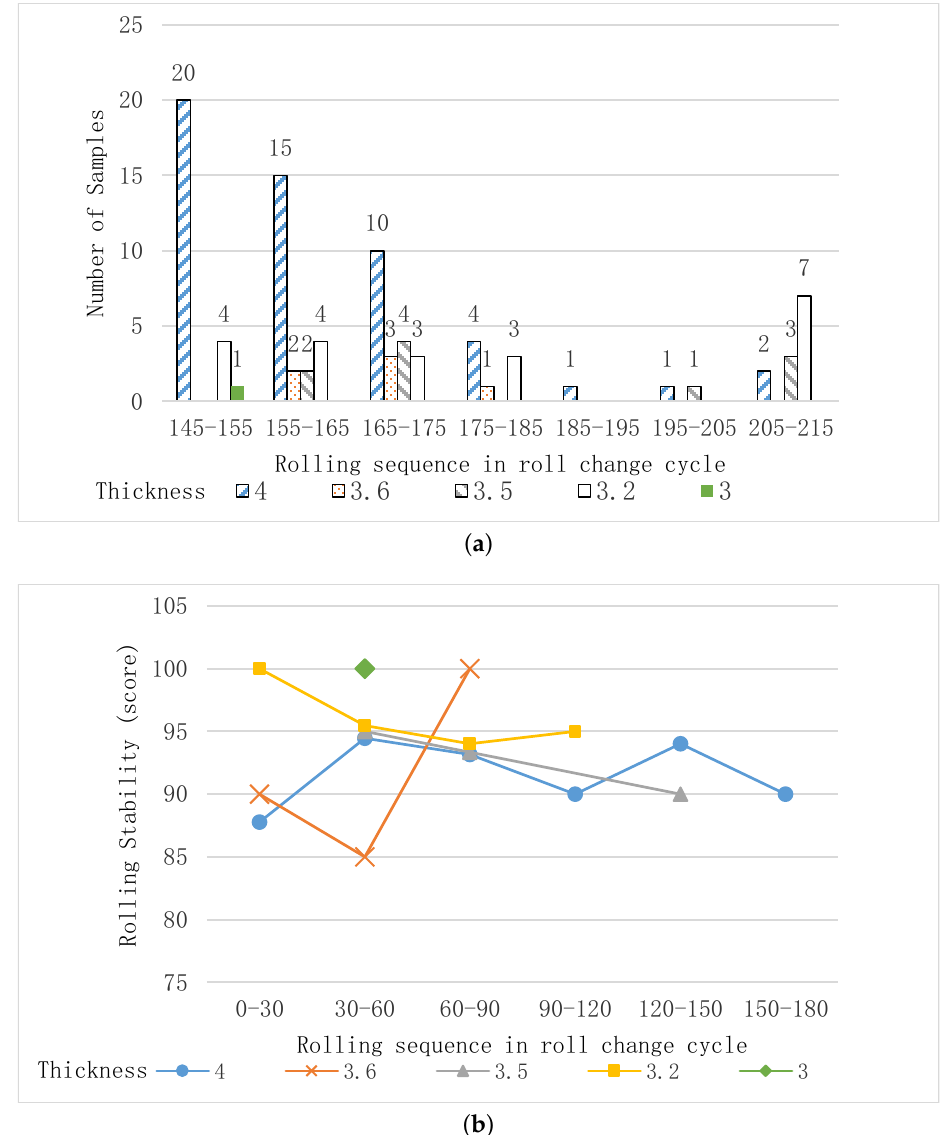
Figure 10. Time in the furnace. ( a ) Sample distribution; ( b ) Stability